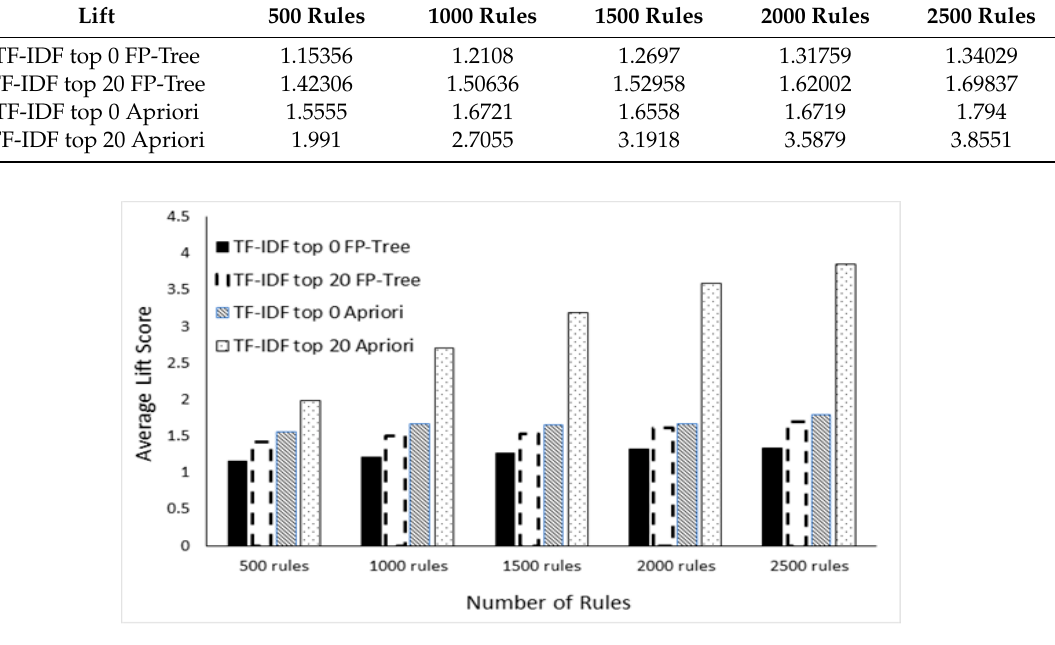
Figure 14. Average Lift Score of Association Algorithms by Number of Rules.